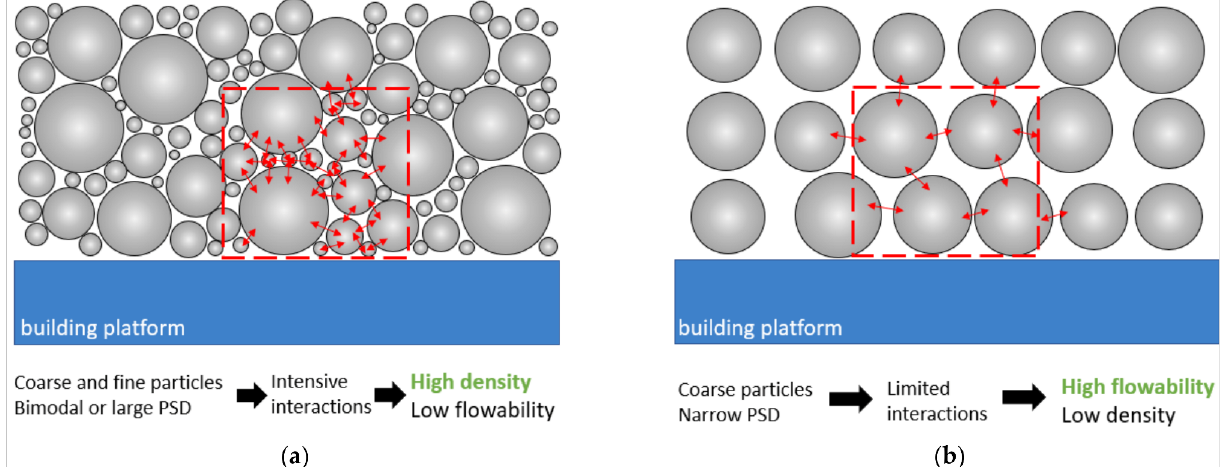
Figure 3. The best scenario for the highest powder packability ( a ) and the best scenario for powder flowability ( b